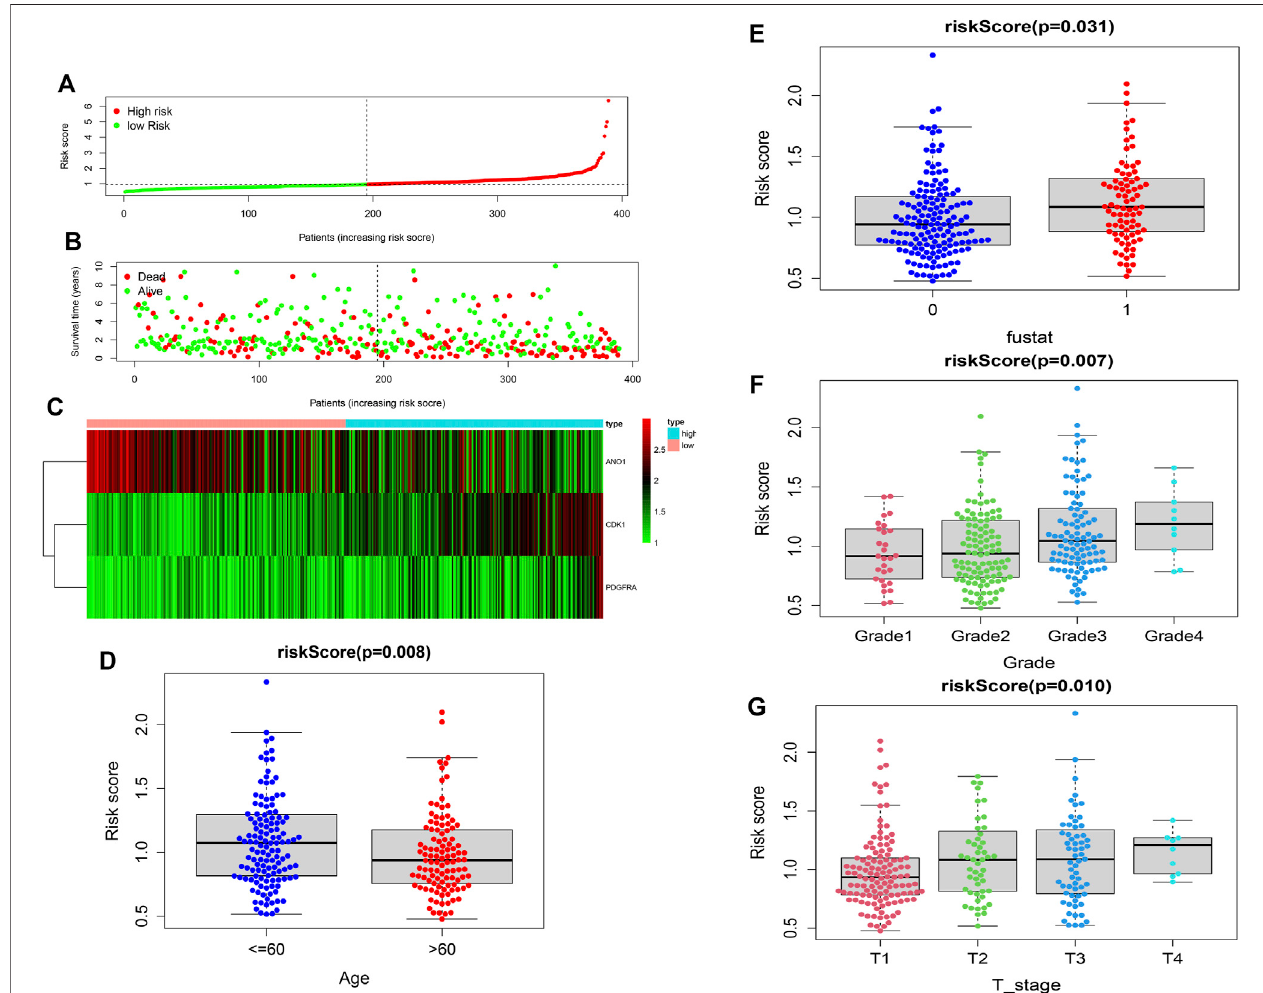
FIGURE 3 | Construction of the risk score. (A,B) Distribution of the survival, risk score, and survival of patients with HCC. (C) Heatmap of the expression of three m7G-related genes in HCC. (D) Relation of the risk score and patient ’ s age. (E) Relation of the risk score with survival status. (F) Relation of the risk score with tumor grade. (G) Relation of the risk score with